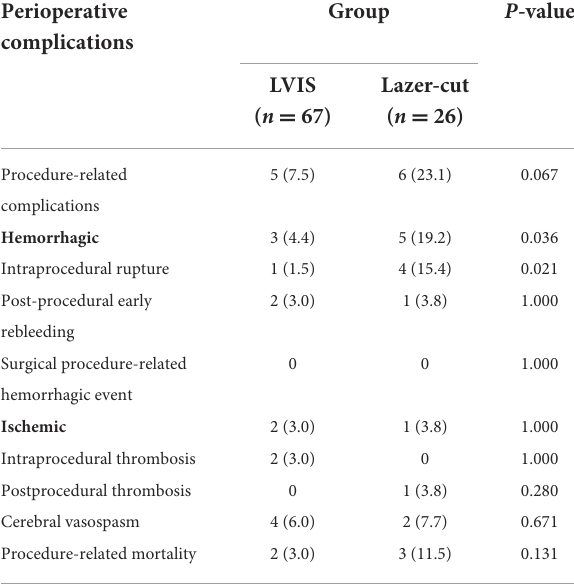
TABLE 5 Perioperative Complications for patients treated with LVIS and laser-cut stent.